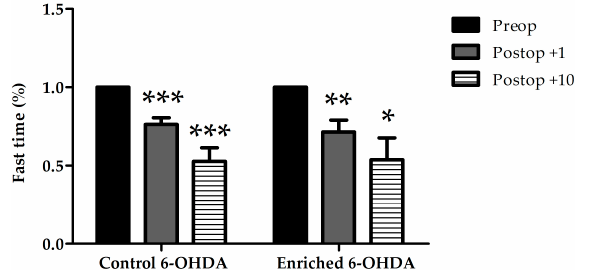
Figure 4. Fast time in 6-OHDA-treated control and enriched animal groups before (Preop), 1 day, and 10 days after the lesion (Postop +1, +10, respectively). In the graph the percentage of fast time is shown compared to preoperative data of the same group. Values are given as mean ± S.E.M., where 100% =